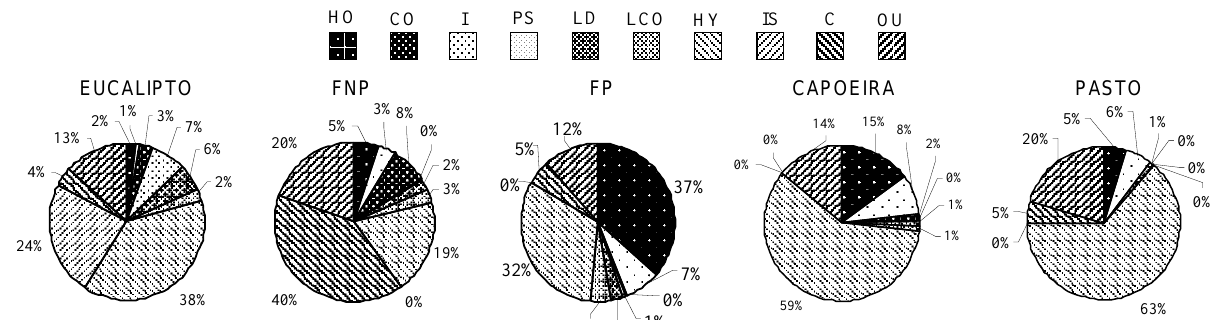
Figura 1. Distribuição dos grupos de fauna identificados na serapilheira das diferentes coberturas vege- tais no verão. HO- Homoptera; CO- Coleoptera; I- Isopoda; PS- Pseudoscorpionida; LD- Larva de Diptera; LCO- Larva de Coleoptera; HY- Hymenoptera; IS- Isoptera; C- Collembola; OU- Outros; FNP- Floresta não preservada; FP- Floresta preservada. * Os dados obtidos no pasto são referentes ao sistema solo- serapilheira, pois não houve separação dos compartimentos.